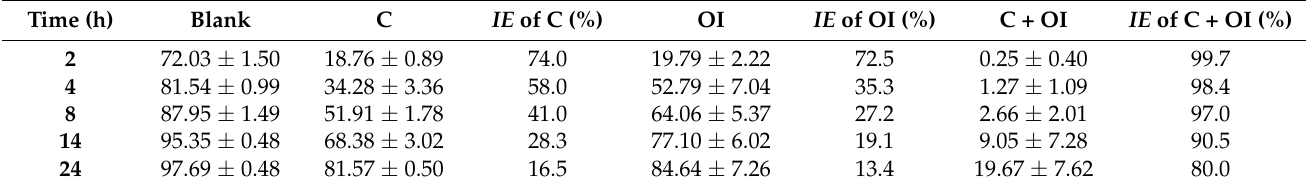
Table 6. Corrosion reduction efficiency according to Equation (6) for the spray corrosion measures at the given